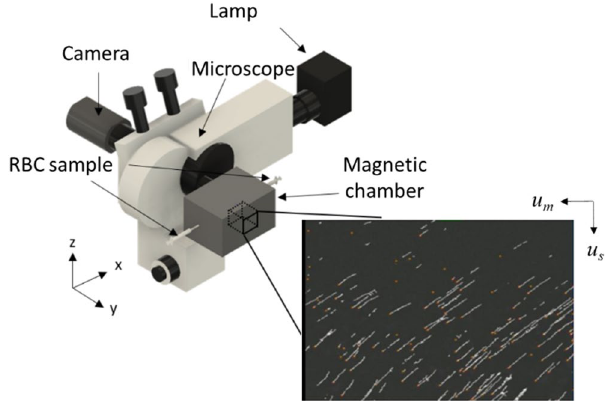
Figure 1. Schematic representation of the CTV instrument (adapted from Ref. 24